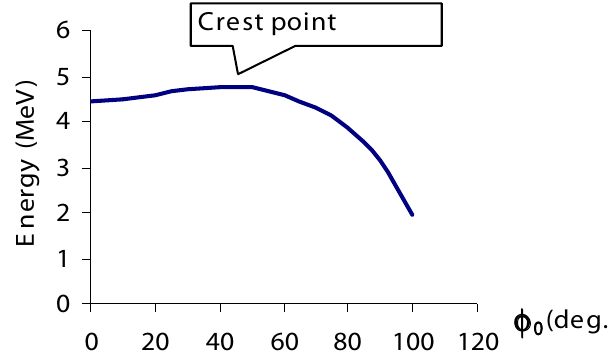
FIG. 16. Beam envelope vs z of an optimized nonmagnetized . 0